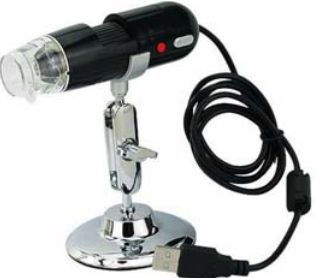
Figure 4: Microscope with a USB interface used for in situ measurements of crack growth.